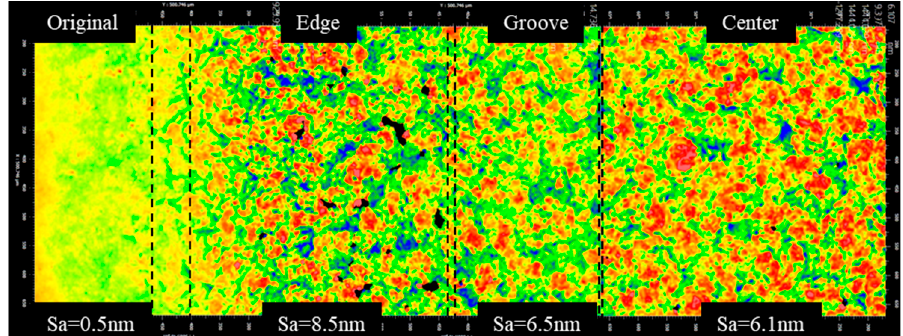
Figure 11. Change in the surface morphology along the radius of the removal pit (gap = 0.15 mm, amplitude = 40 μ m, time = 300